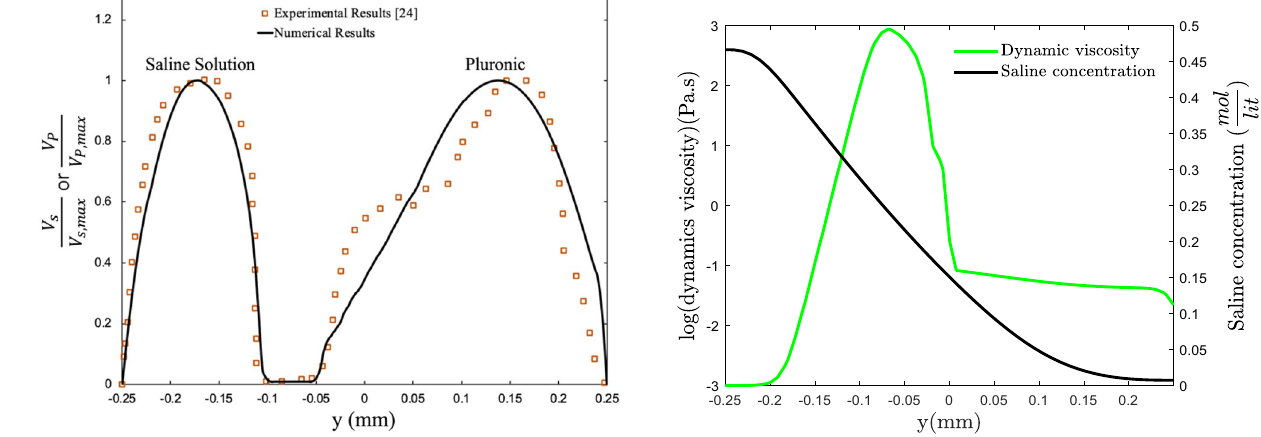
Fig. 5 Changes in sodium phosphate concentration and dynamic viscosity in logarithmic scale through the channel’s height after